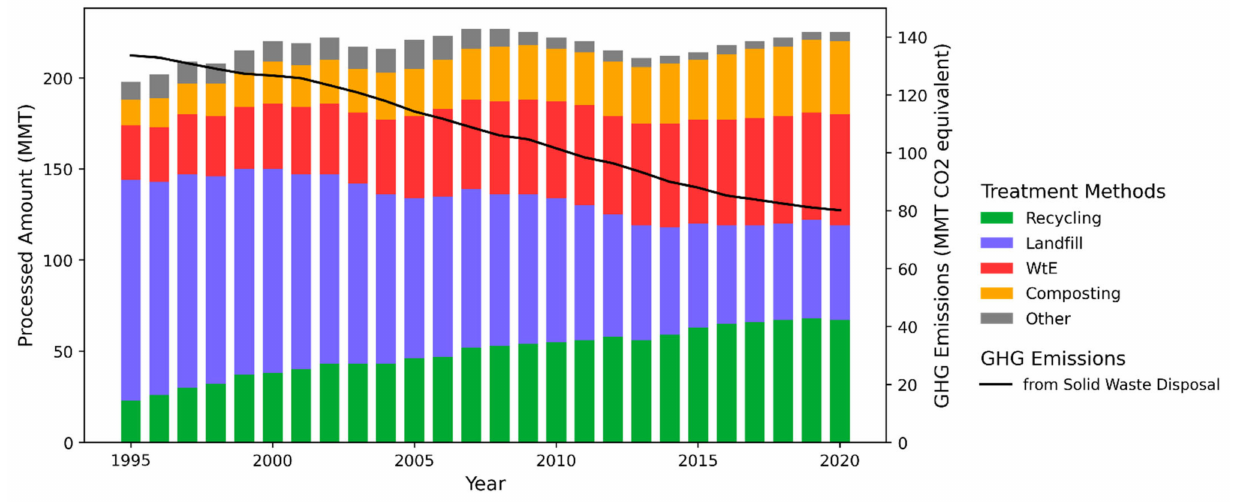
Figure 7. Changes in EU generation and disposition of MSW, and associated GHG emissions, from 1995 to 2020